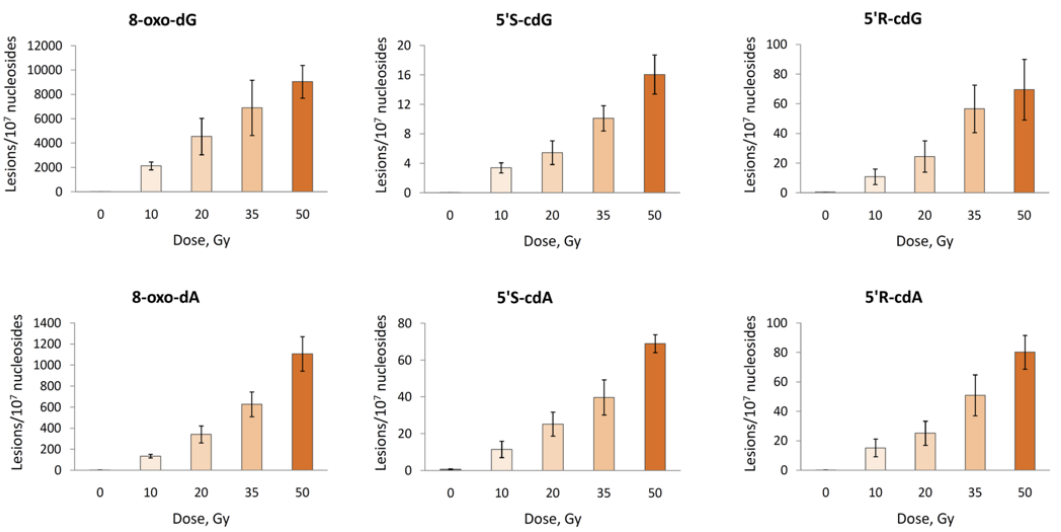
Figure 8. Radiation induced formation of 8-oxo-dG, 5 ′ S -cdG, 5 ′ R -cdG, 8-oxo-dA, 5 ′ S -cdA and 5 ′ R -cdA in ct-DNA Procedure (i). Each sample was exposed to 0, 10, 20, 35, and 50 Gy dose. The values represent the mean ± SD of n = 3 independent experiments.